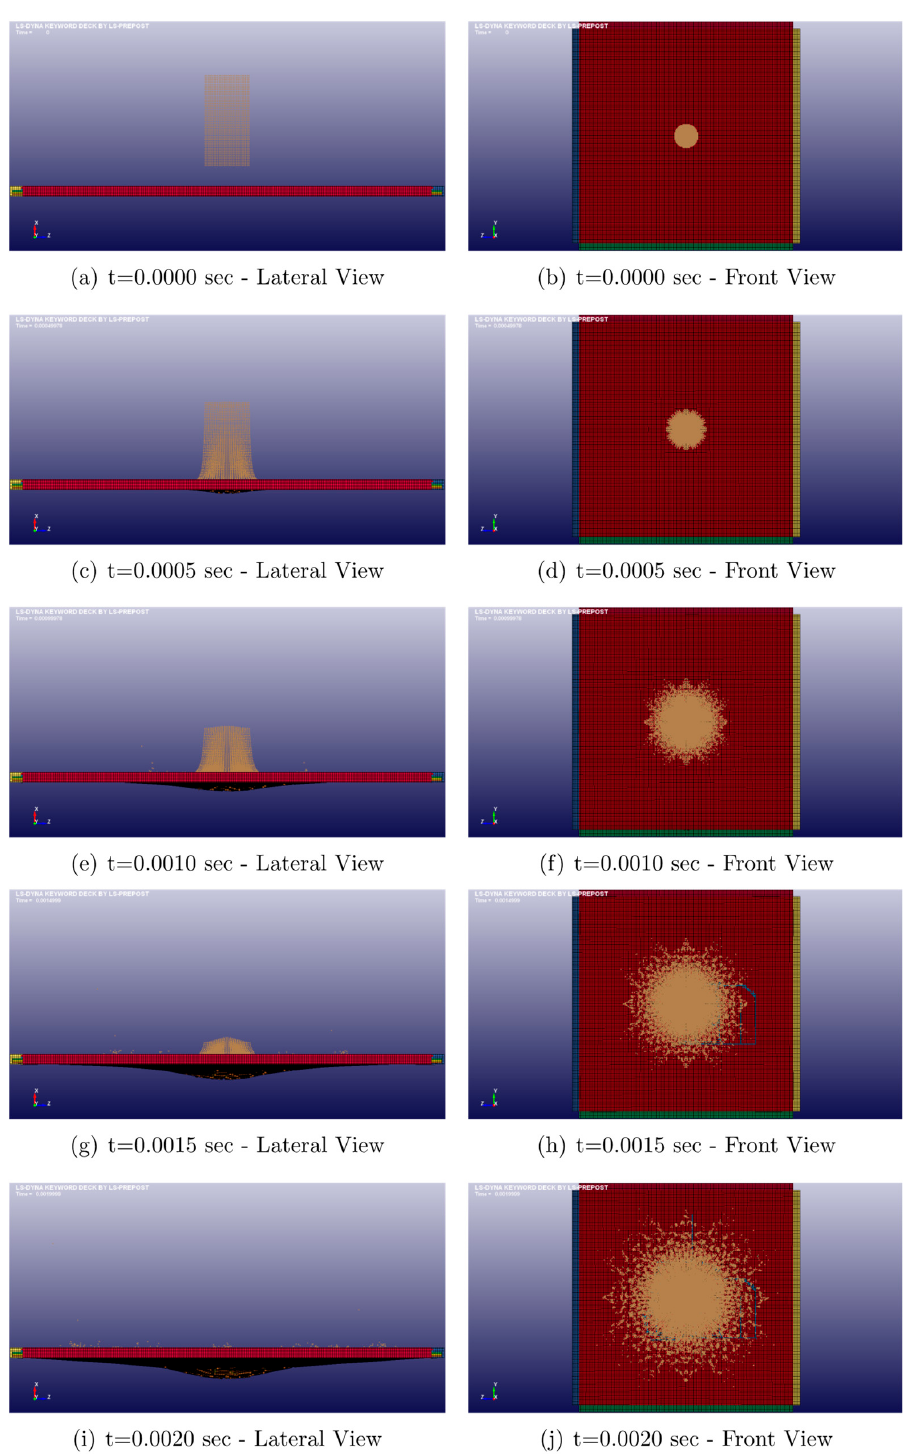
Figure 10. Sequence of plate deformation up to 2 ms